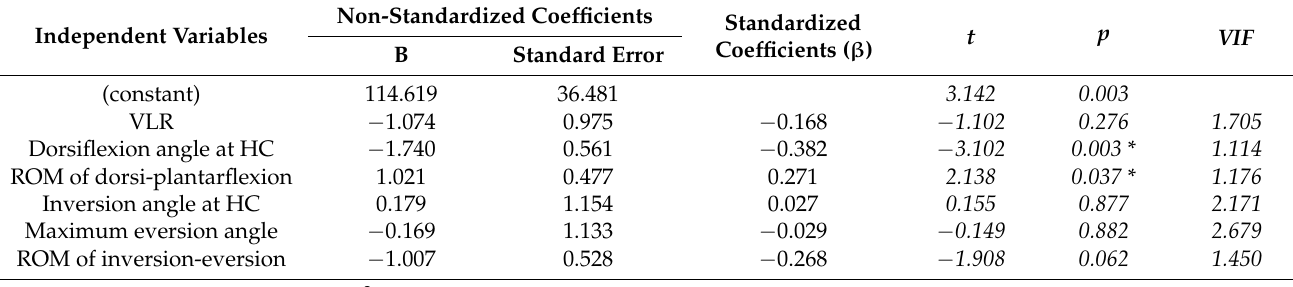
Table A4. Descriptive information of multiple regression analysis for shoe comfort using biomechanical